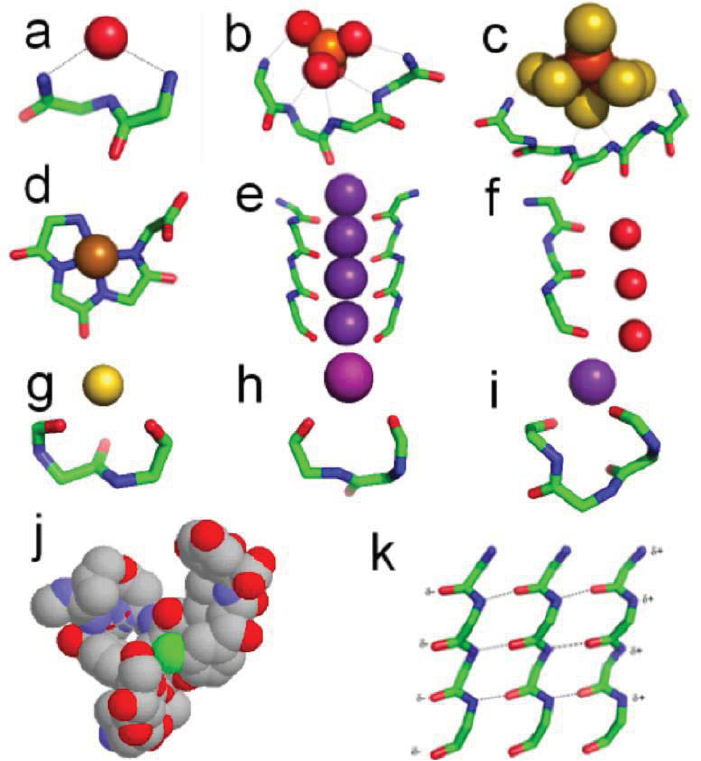
Figure 2. Motif structures ( a ) nest binding a carbonyl oxygen. ( b ) nest binding a phosphate S iron-sulfur center. ( d ) covalent Ni + -tetrapeptide complex — a ion. ( c ) nest binding a Fe 4 4 peptide pigment. ( e ) two of the four peptides forming the selectivity filter of the potassium channel . ( f ) the peptide forming the aquaporin channel. ( g ) catgrip bound to a calcium ion . ( h ) niche3 bound to a K + ion. ( i ) niche4 bound to a K + ion. ( j ) vancomycin, which can be regarded as a nest designed to bind a carboxylate group in the bacterial cell wall (the carboxylate of acetate is seen in sticks and the antibiotic is in spacefill) . ( k ) three strands of (cid:2) -sheet. (note the similarity in conformation with e and f). (cid:2) -sheet, unlike (cid:3) -sheet, has an inherent polarity, indicated by the partial charges (cid:4) + and (cid:4) − . In ( a-i ) and ( k ) the side chains are omitted. Colors: carbon, green; oxygen, red; nitrogen, blue; sulfur, mustard; potassium, purple; iron, rust; nickel, brown; chlorine, green; calcium, yellow; phosphorus,